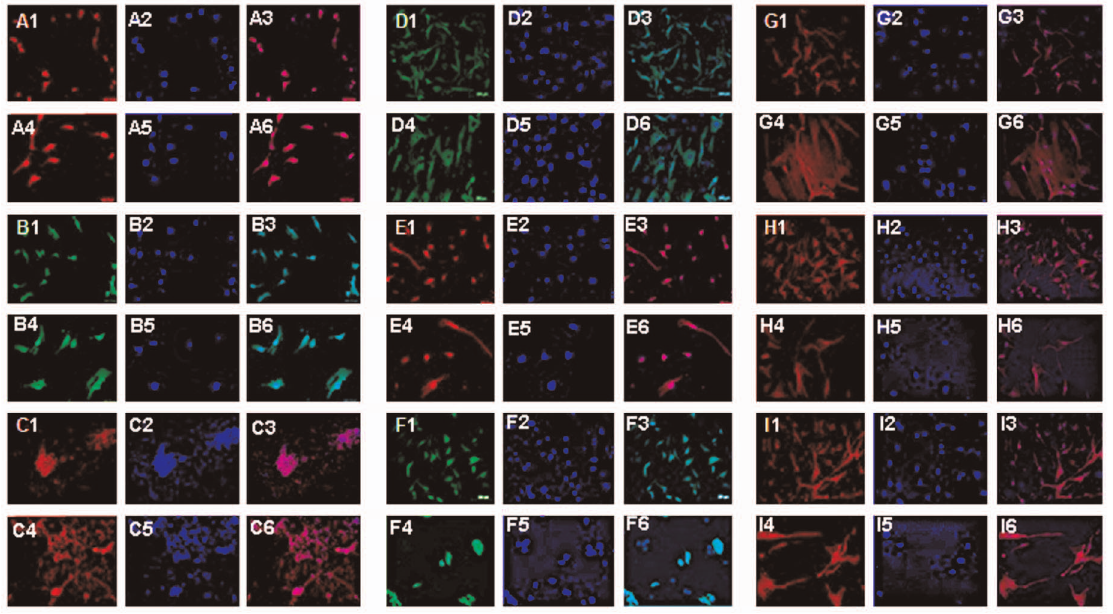
Figure 2. DPCs maintain stemness and differentiate into neural cells under appropriate conditions over multiple passages. Stem cell under proliferation medium and neural cell markers under differentiation medium were detected at passage 10. The DPCs expressed the stem cell markers, Oct-4 (A), SSEA (B), Nanog (D), and CXCR4 (E), and the neural cell markers, NeuN (C), GFAP (F), Nestin (G), MAP2 (H), and O4 (I). 1,4: phenotypic marker; 2,5: DAPI; 3,6: Merged. 1–3: 10X; 4–6: 20X.